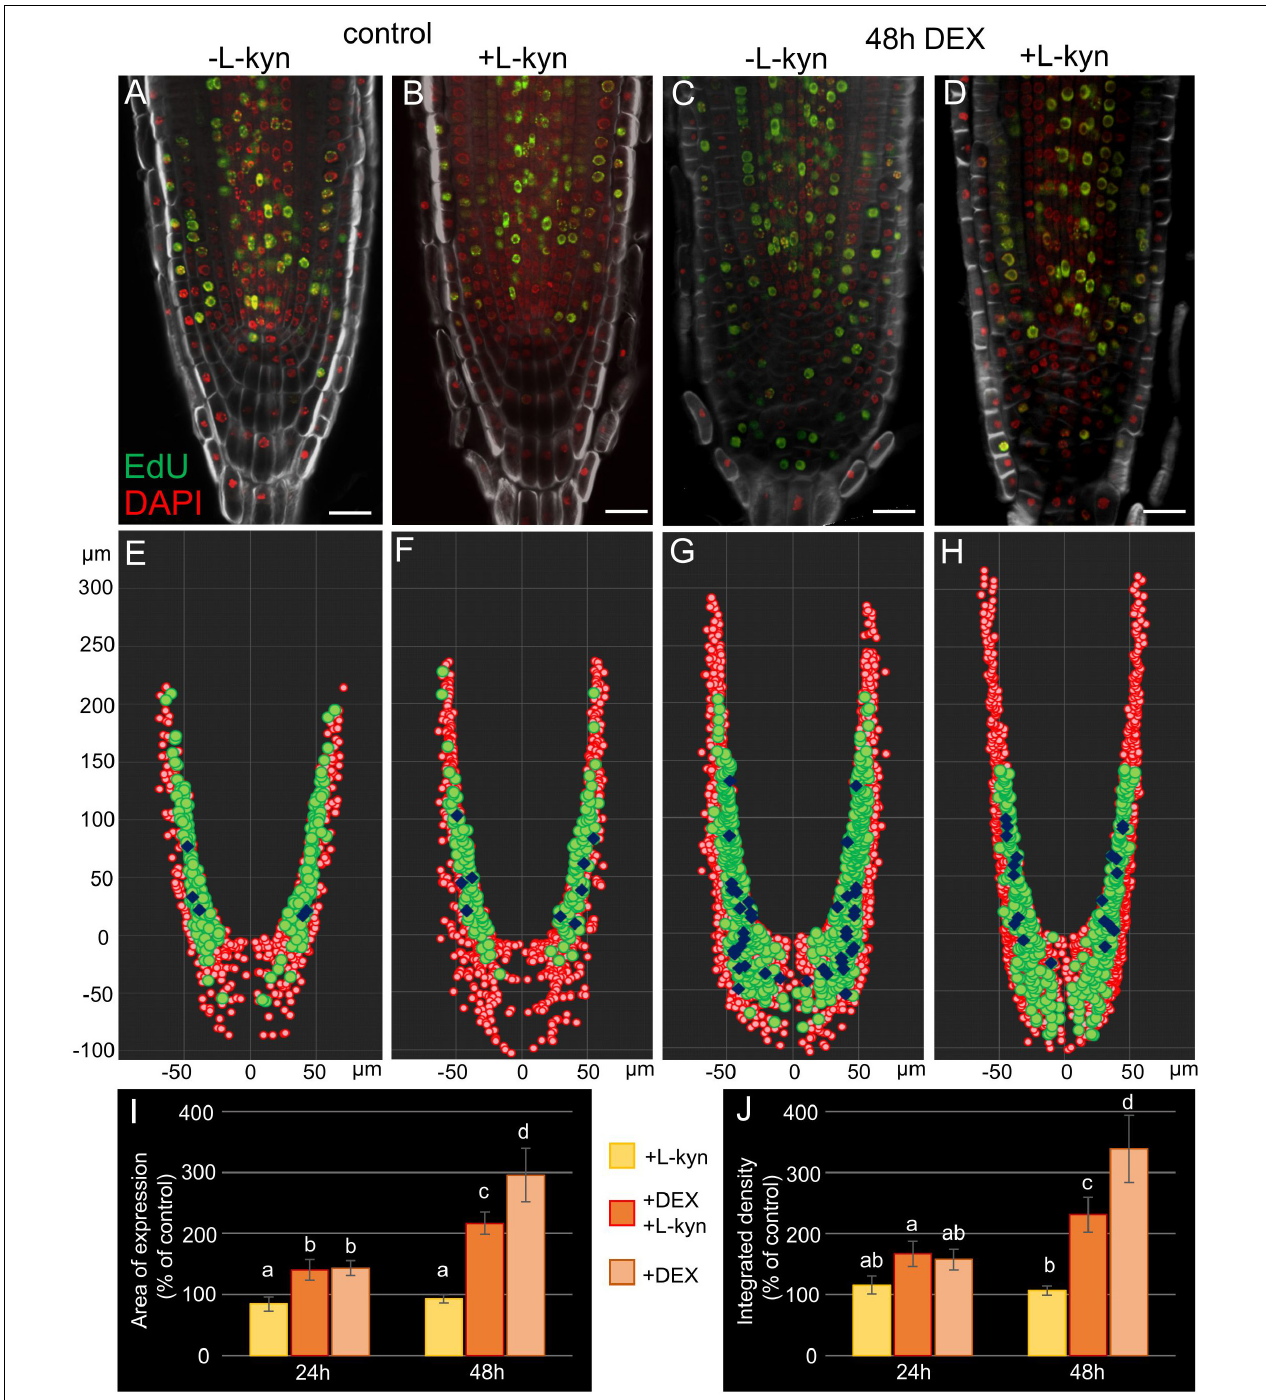
FIGURE 7 | Auxin synthesis inhibitor L -kynurenine partially restores the wild type root tip phenotype in DEX-induced 35S:WOX5-GR plants. (A–D) EdU-labeling of 35S:WOX5-GR root tips after 48 h treatment with mock (A) , L -kynurenine (B) , DEX (C) , and DEX with L -kynurenine (D) . EdU is in green counterstained with DAPI in red and BR28 in white. The bar scale – 20 µ m. (E–H) The nuclei distribution maps for the representative root tips of 35S:WOX5-GR (A–D) quantitatively analyzed in 3D with iRoCs Toolbox (Schmidt et al., 2014). The nuclei projections to the longitudinal cut are depicted as red circles, EdU-labeled nuclei as green circles, mitotic ones as blue rhombs. (I,J) Quantitative analysis of the expression area (I) and integrated fluorescence density (J) in 35S:WOX5-GR TAA1:TAA1-GFP root tips. The TAA1-GFP fluorescence changes measured upon L -kynurenine exposure (+ L -kyn), simultaneous action of L -kynurenine and dexamethasone (+ DEX + L -kyn), and dexamethasone exposure (+ DEX) after 24 and 48 h relative to the mock treatments. The statistical significance was estimated by one-way ANOVA with Tukey post hoc test (CI 95%, N = 20): letters “a,” “b,” “c,” and “d” denote significantly different groups of samples.